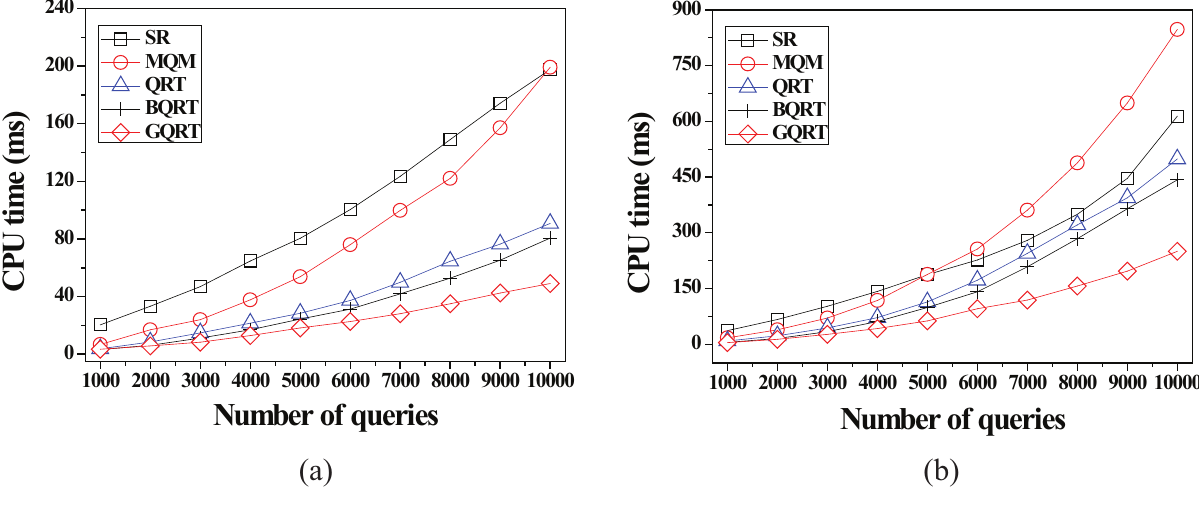
Figure 8. CPU-time vs . cardinalities of Uniform and Skewed . ( a ) Uniform ; ( b ) Skewed